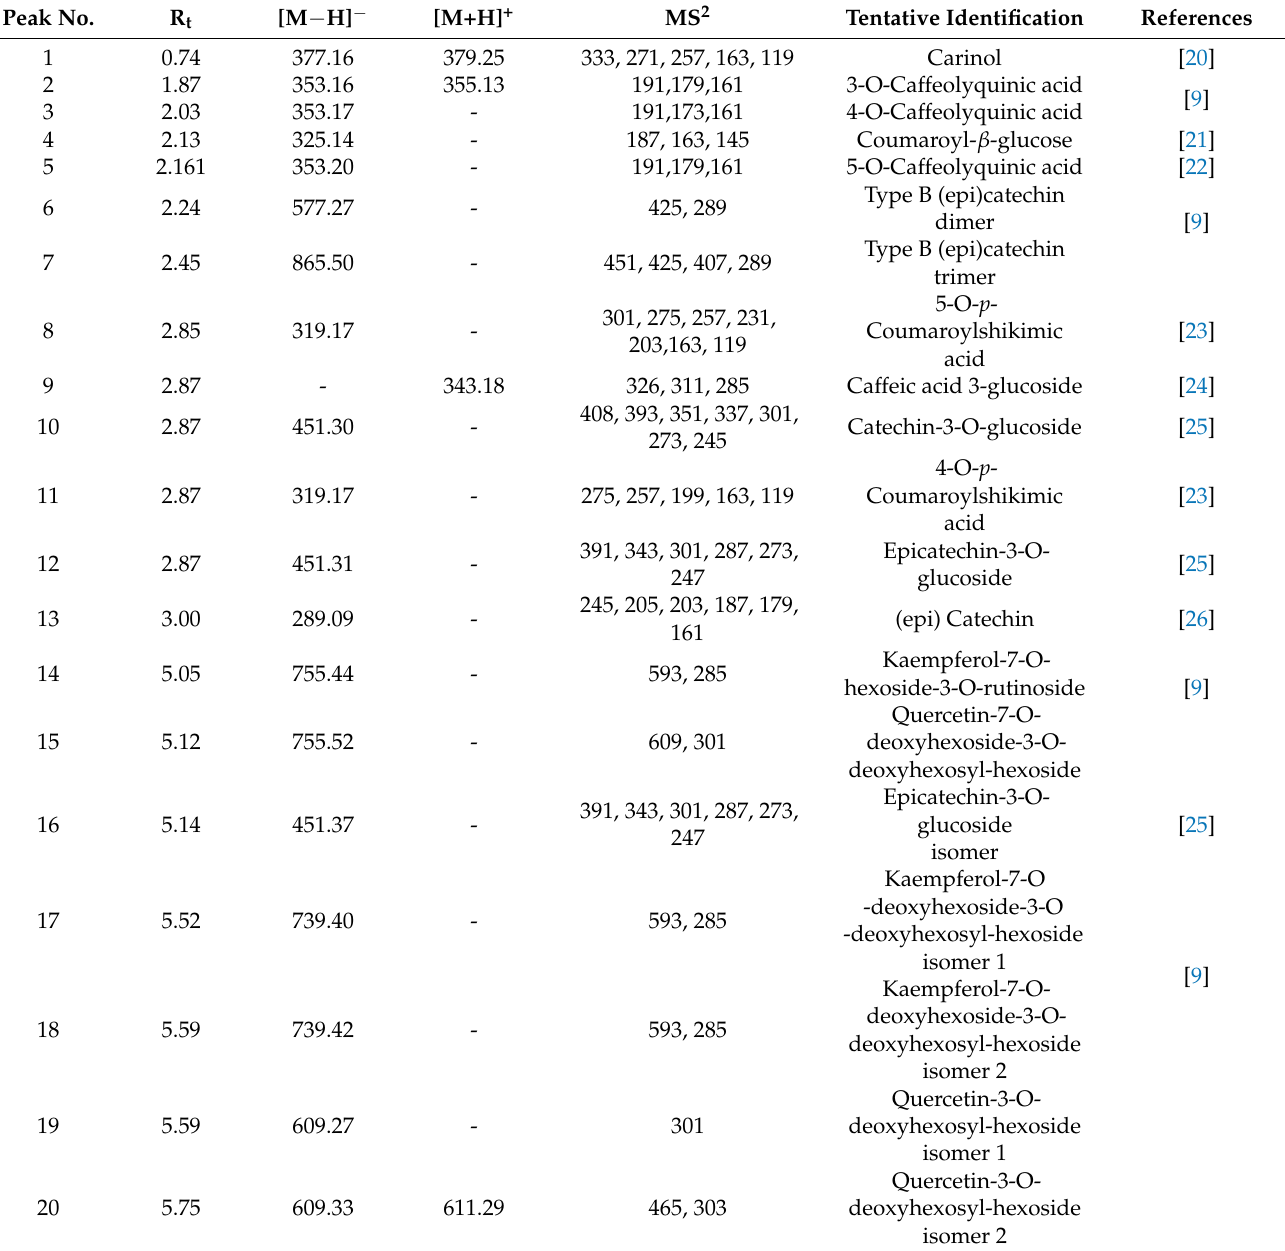
Table 1. Secondary metabolites identified in the C. macrocarpa leaves polar fraction using UPLC-ESI-MS-MS. Peak